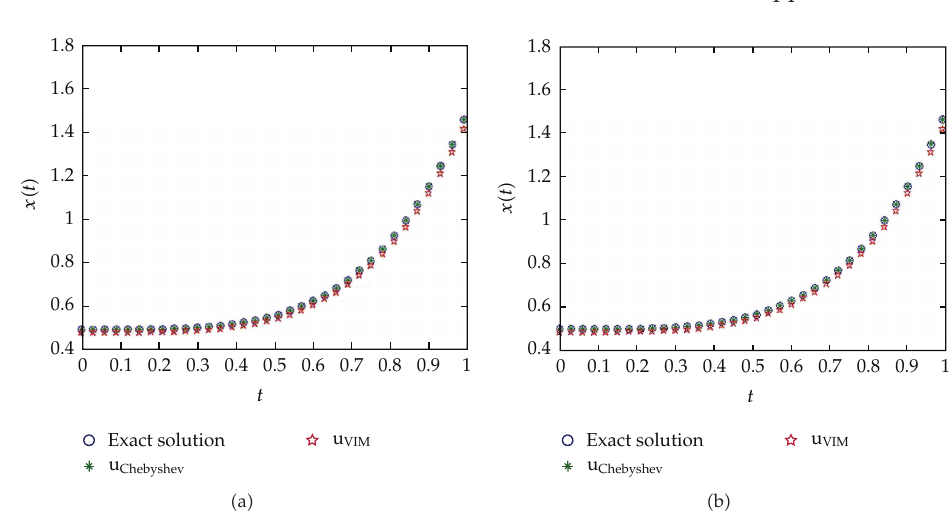
Figure 1: The behavior of the numerical solution (cid:3) at α (cid:8) 1 ,ρ (cid:8) 0 . 5 (cid:4) using ChebM with (cid:3) m (cid:8) 6 (cid:4) and VIM at r 1 (cid:8) 0 . 0, r 2 (cid:8) 0 . 7 (cid:3) a (cid:4) and r 1 (cid:8) r 2 (cid:8) 0 . 7 (cid:3) b (cid:4)